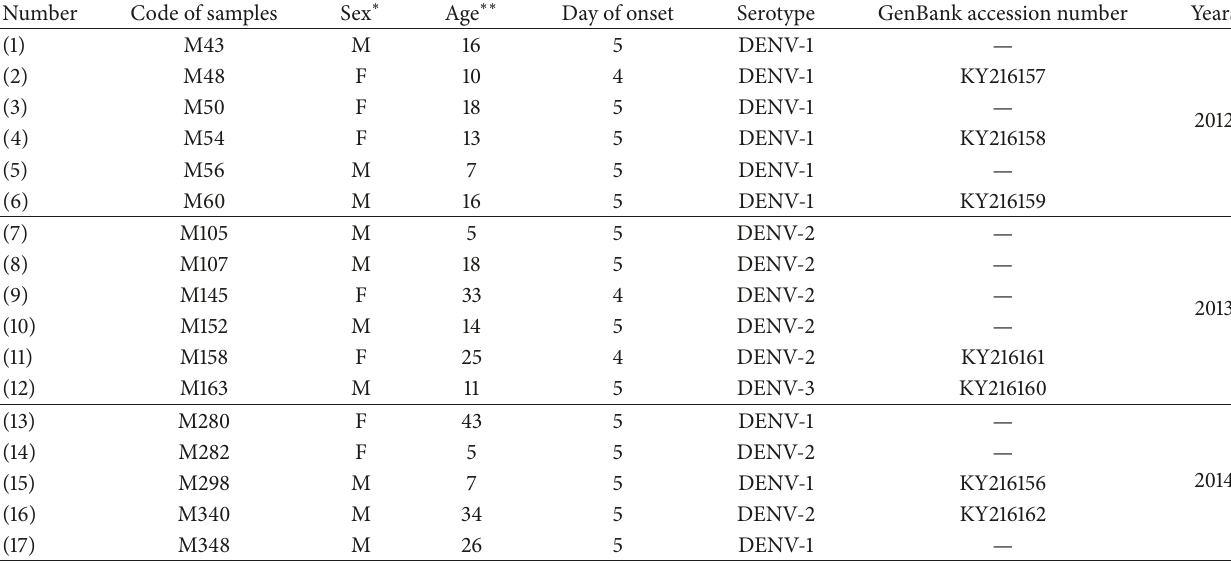
∗ F: female; M: male. ∗∗ Age of patients in